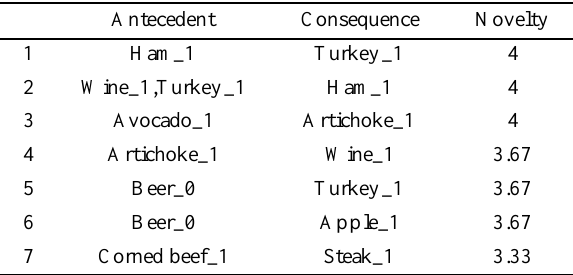
Table 4. Missing rule set M in market basket data mining